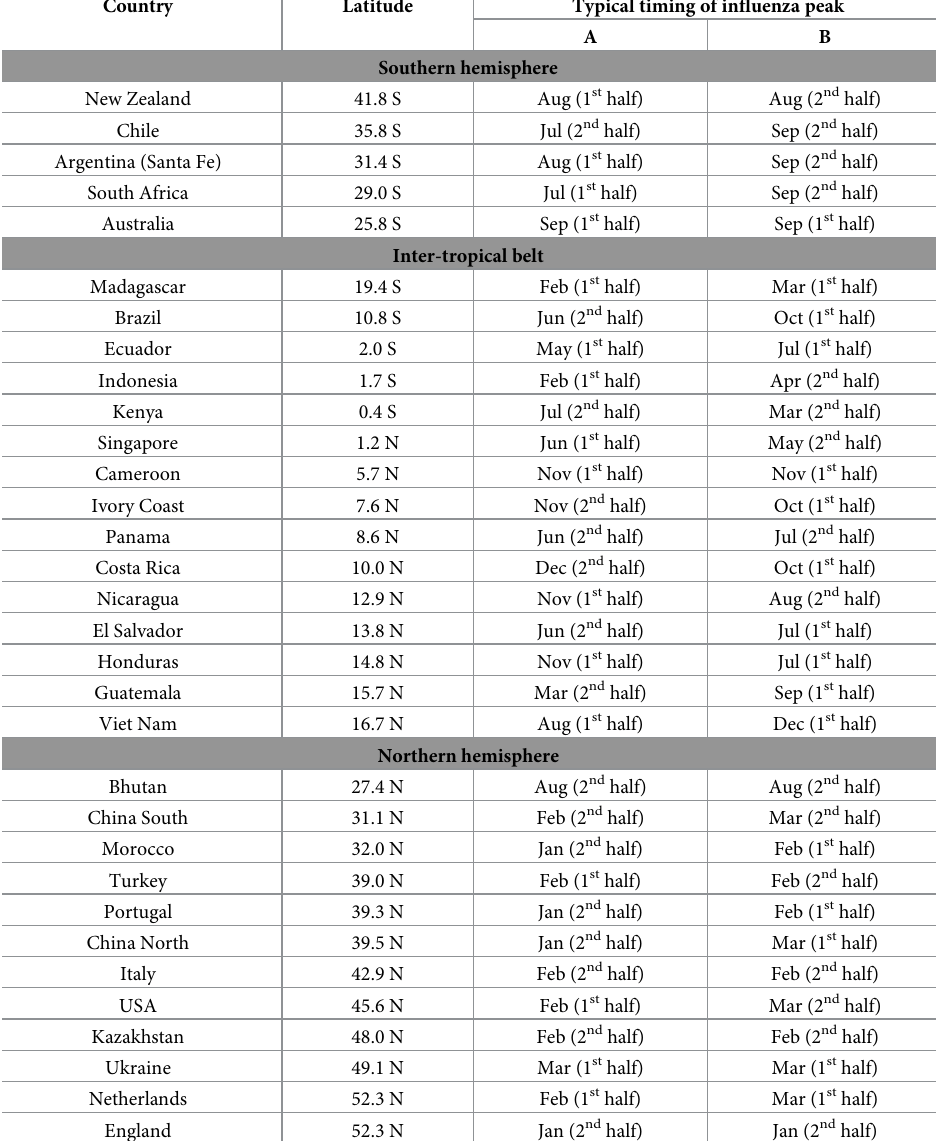
Table 1. Typical timing of the peak of influenza A and B epidemics according to countries’ latitude. The Global Influenza B Study, 2000–2018. Country